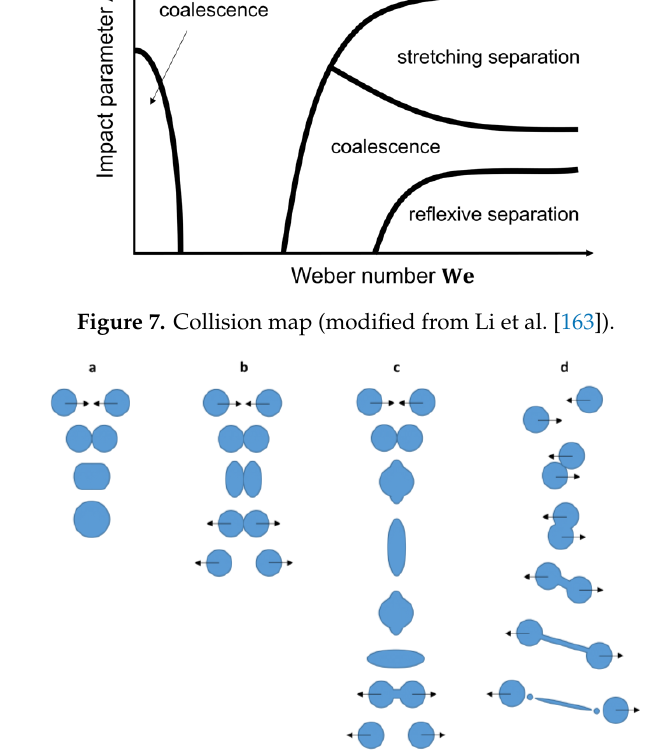
Figure 8. Schematic illustration of the four collision regimes: ( a ) coalescence, ( b ) bouncing, ( c ) reflexive separation, and ( d ) stretching separation (modified from Charalampous et al. [167]).